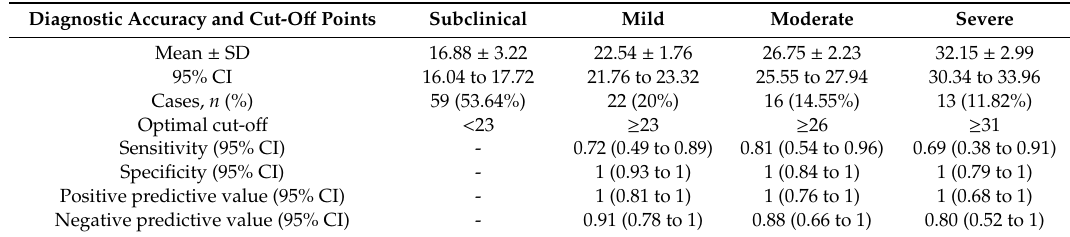
Table 5. Diagnostic accuracy results and all optimal cut-o ff